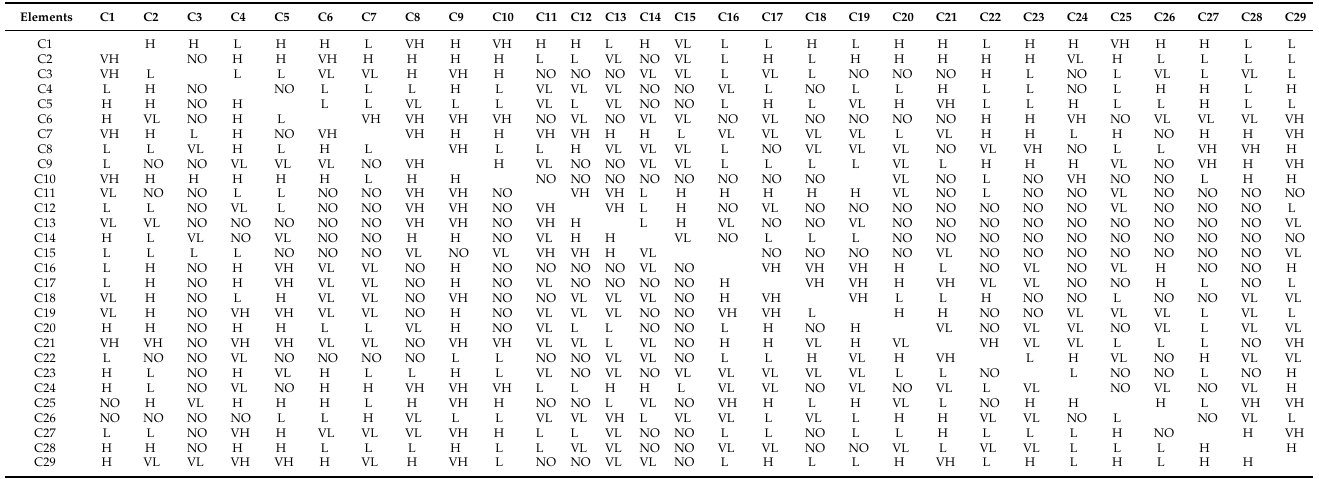
Table 3. An example of original data from one of the experts.